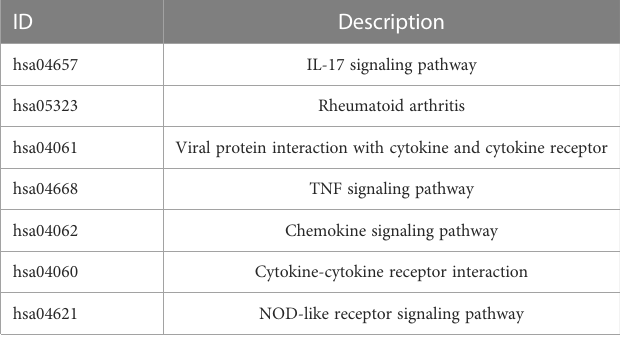
TABLE 2 KEGG enrichment results for 65